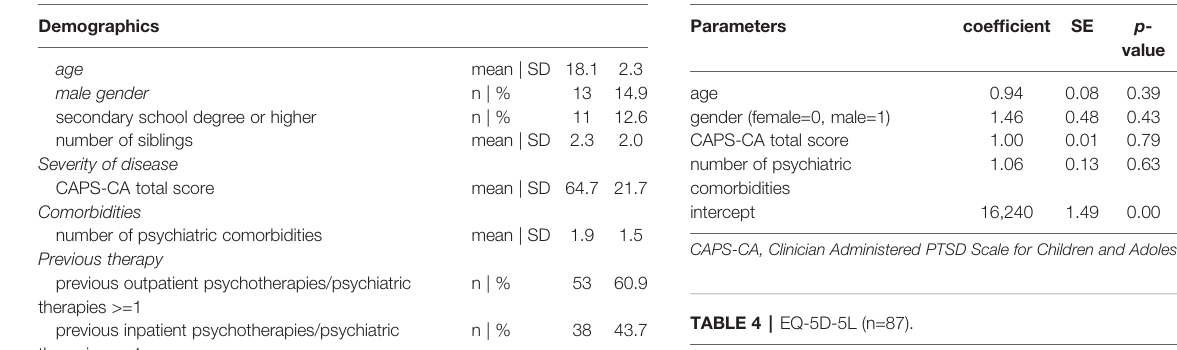
TABLE 1 | Sample characteristics (n=87).